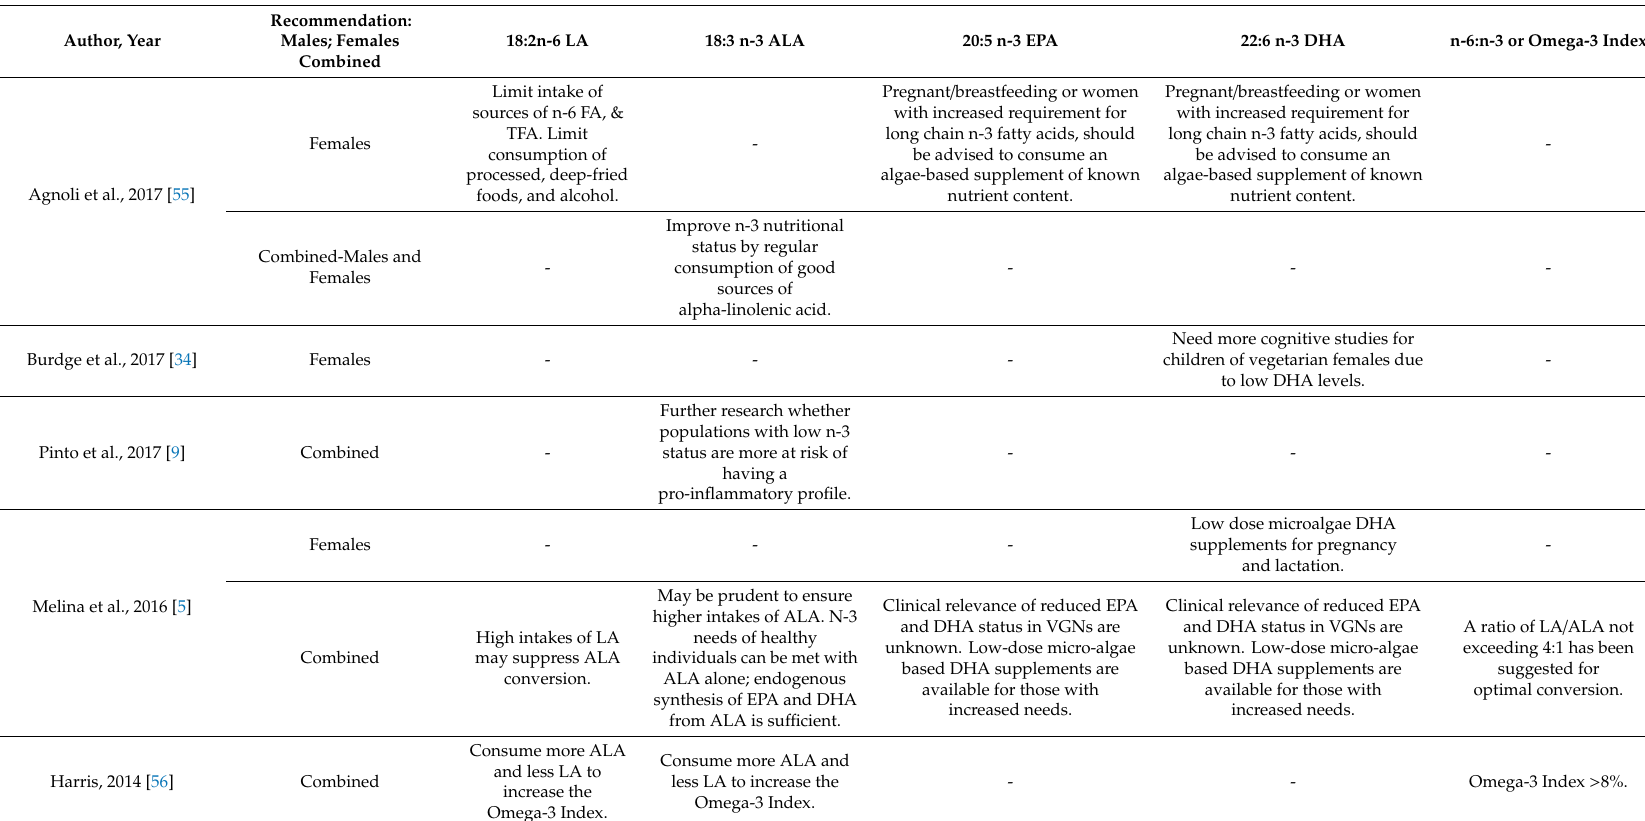
Table 4. Recommendations by researchers and reviewers for adult vegans / total vegetarians (VGNs) (most recent studies